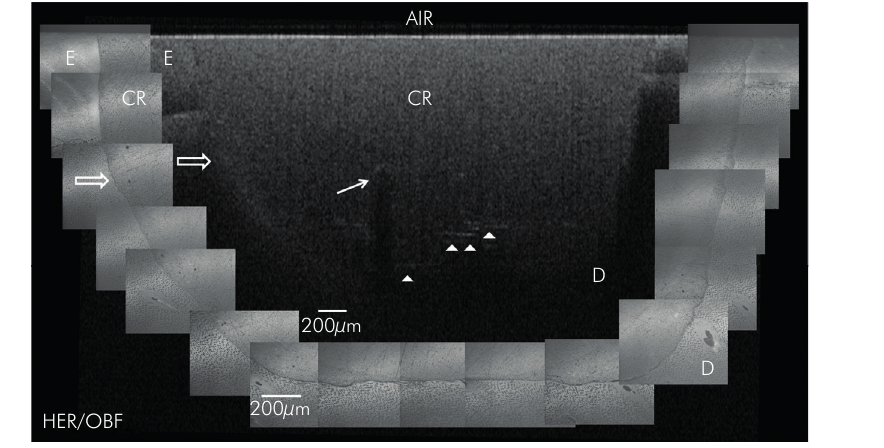
Figure 4. Representative 2D OCT image of HER/OBF and its corresponding CLSM image. Almost no increase in signal intensity (brighter pixels) were observed at the interface, indicating a good sealing ability as pointed by the blank arrow. A void could be observed in the OCT image as pointed by the arrow at the composite. Bold arrowheads are pointing toward defects at the composite, suggesting phase separation inside the